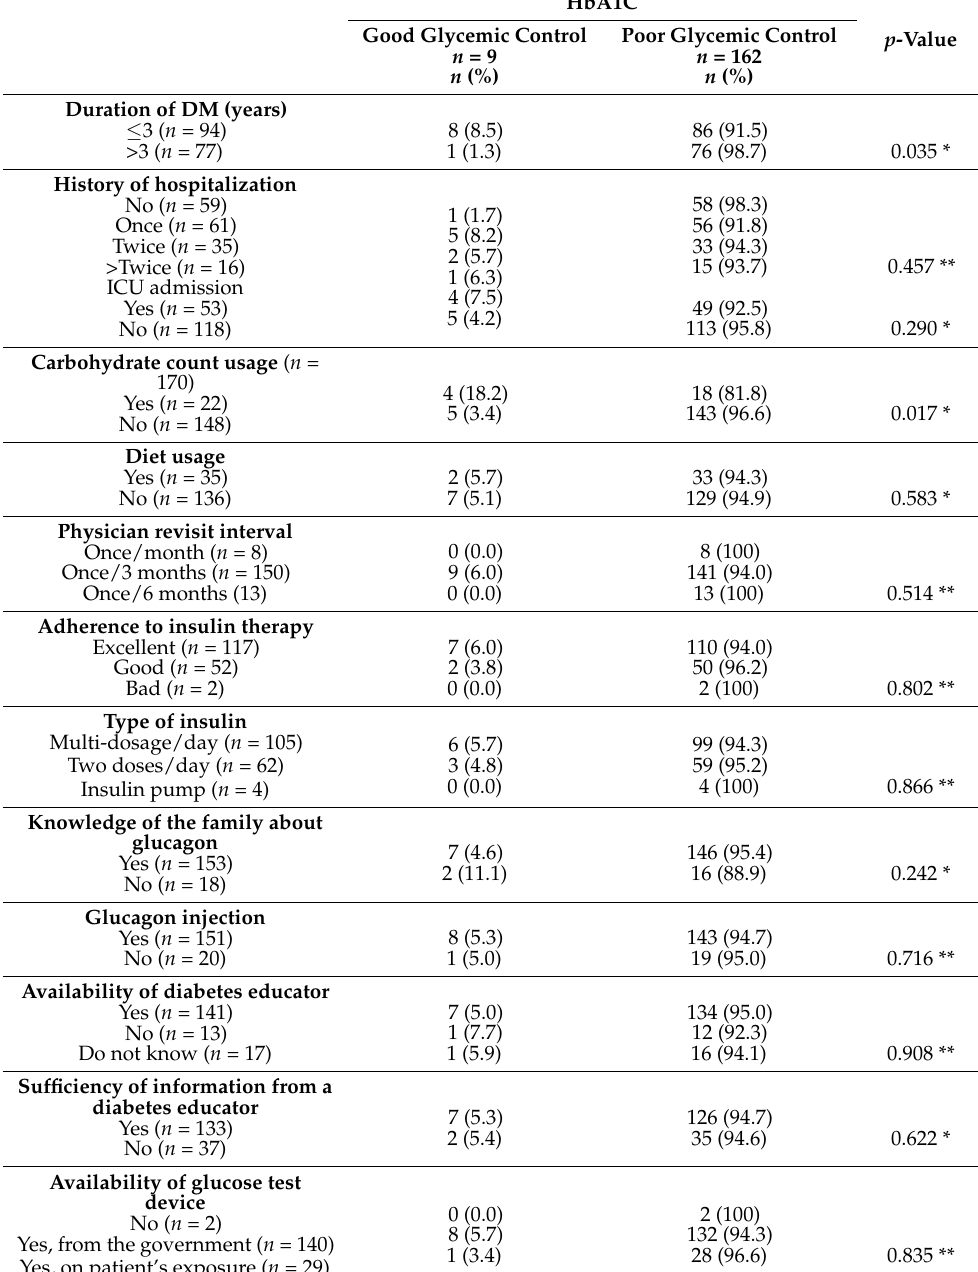
Table 2. Diabetes mellitus related factors associated with level of HbA1c among children in Aseer Region.